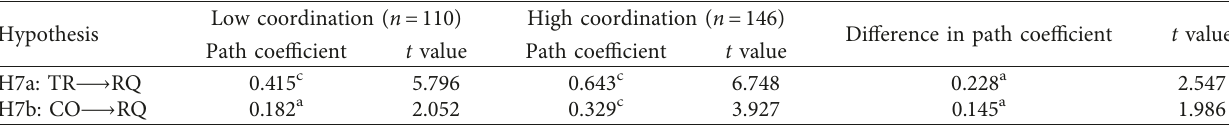
Table 7: PLS analysis of different levels of contractual coordination.